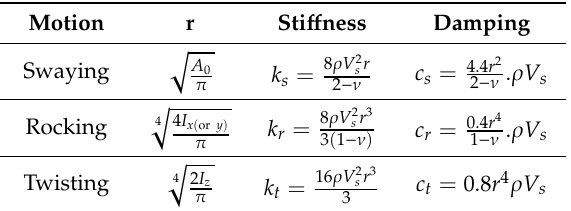
Table 1. Dynamic properties of the springs and dashpots in the swaying, rocking and twisting directions for simulating soil–structure interaction (SSI) effects [32].